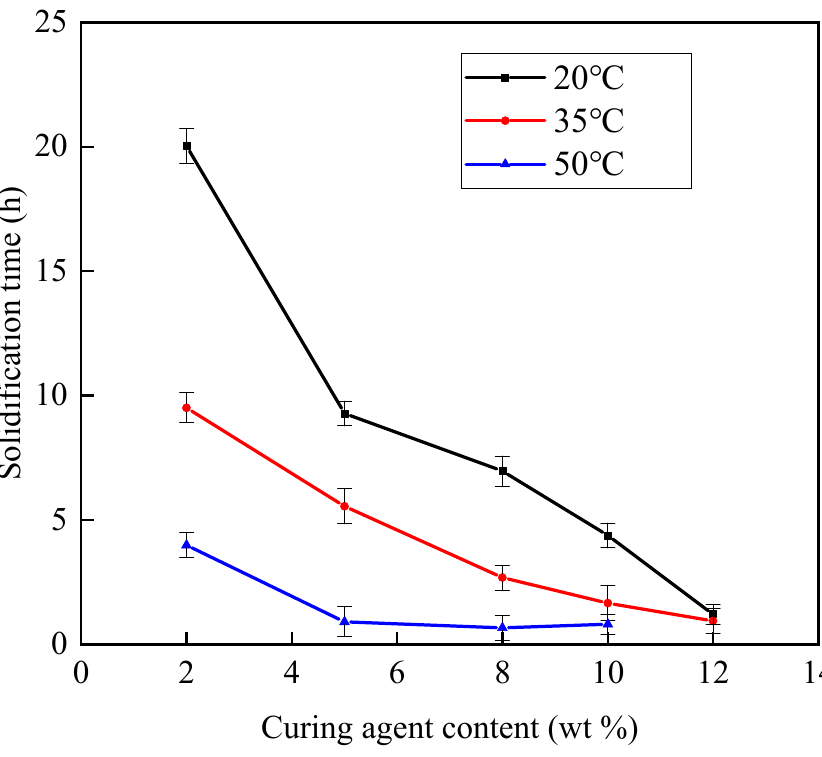
Figure 9. Curing time curve of sealant under different curing agent content.